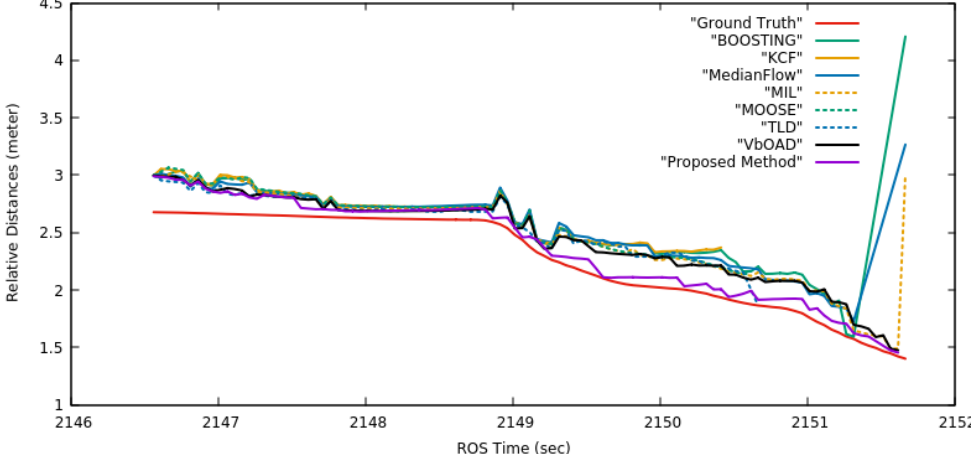
Figure 15. Comparative analysis of deviation of the estimated relative distance with actual relative distance of Husky2 from Husky1. All estimations are in the camera coordinate frame c